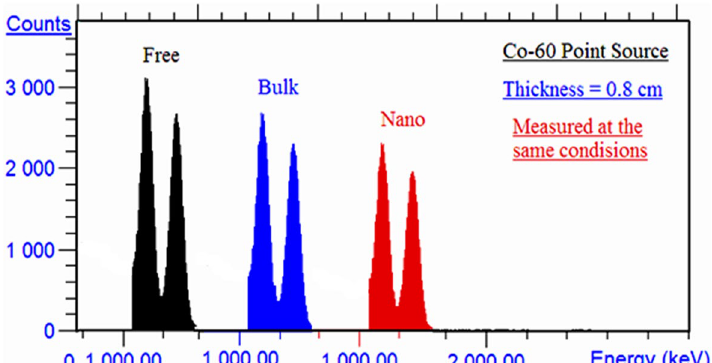
Figure 3. Spectrum of counts for Co-60 Source in case without absorber (Black color), with SRM-20 absorber sample (Blue color) and with SRM-20 absorber sample (Red